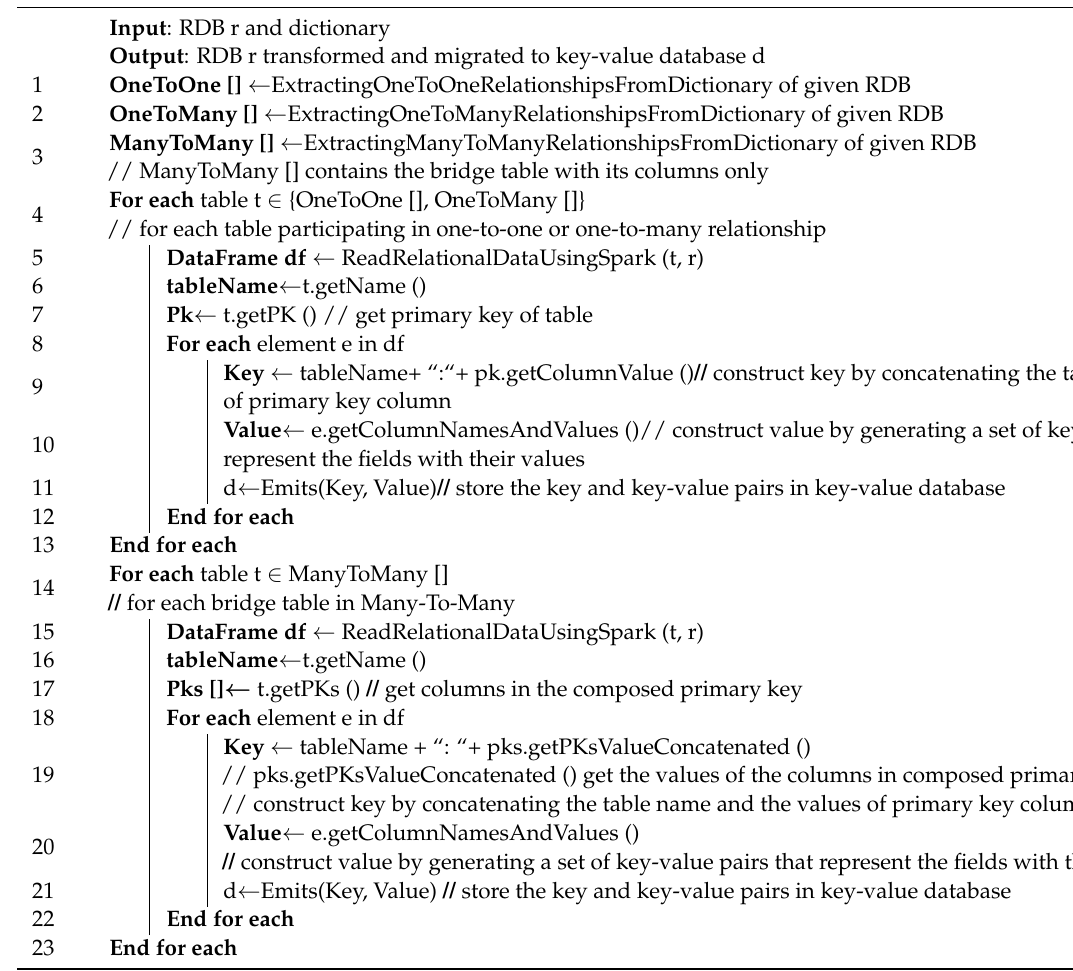
Algorithm 3 : TRANSFORMATION AND MIGRATION FROM AN RDB TO KEY–VALUE MODEL